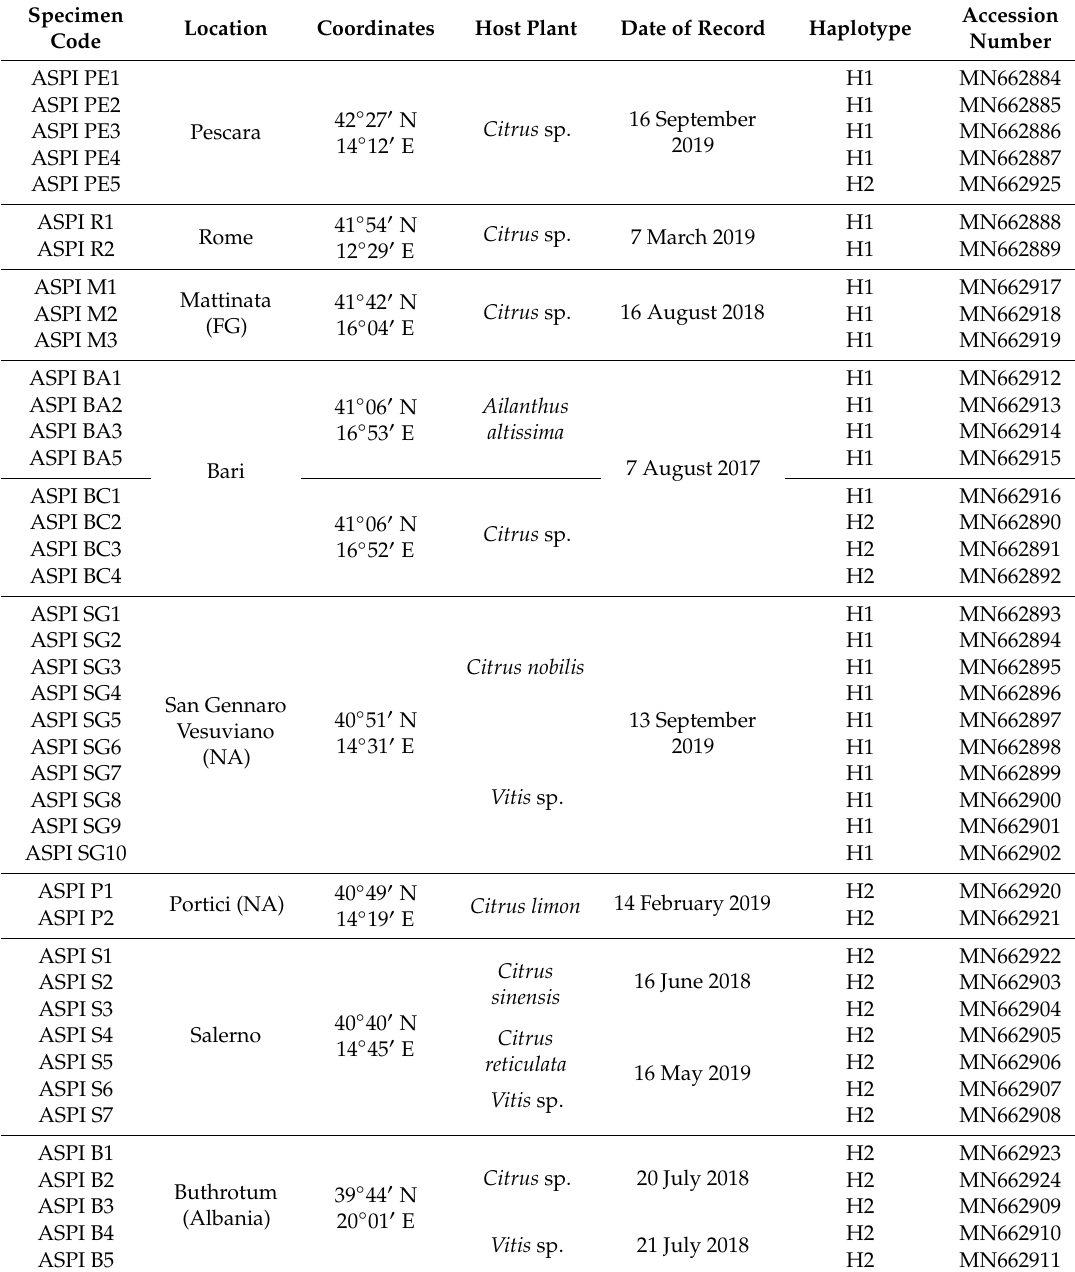
Table 1. Information about the specimen involved in this study and respective haplotyping results and sequences accession numbers. FG, Foggia; NA,